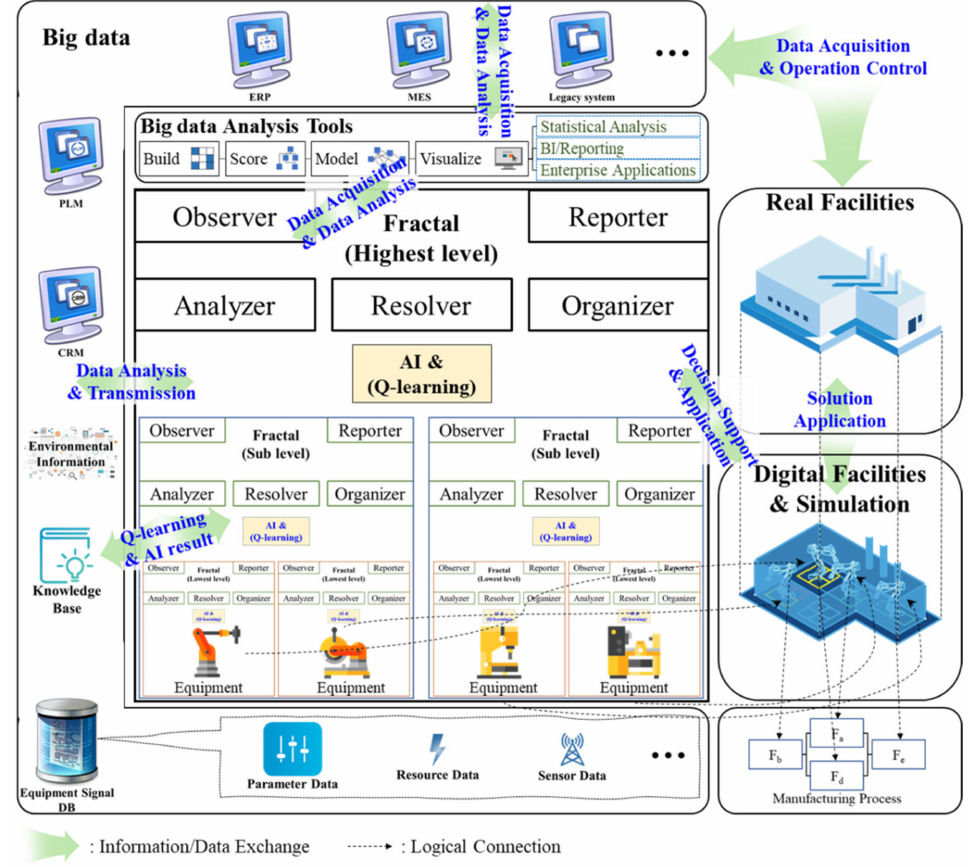
Figure 9. Architecture of